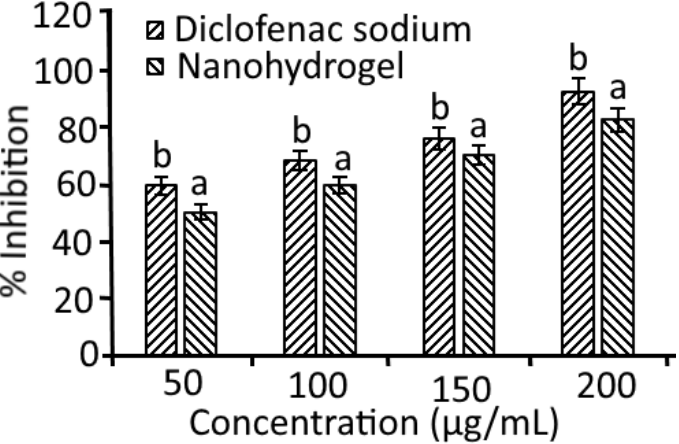
Figure 8. Anti-inflammatory activity of Azadirachta indica oil nanohydrogels. Data are presented as means ± SD (n = 3). a,b Means within the column with different lowercase superscripts are significantly different ( p < 0.05).